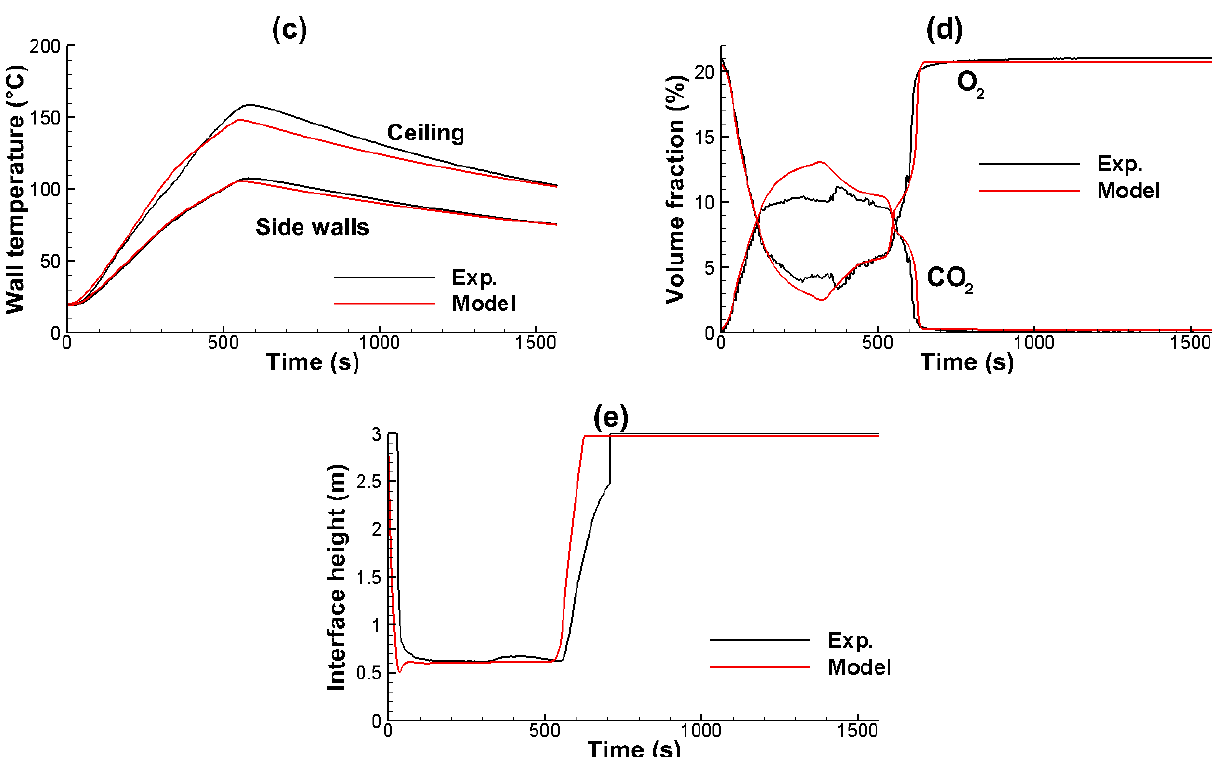
Figure 12. Test 4: ( a ) individual and total HRRs, ( b ) average gas temperature, ( c ) average wall temperatures, ( d ) volume fractions of O 2 and CO 2 in the exhausted gases, and ( e ) smoke layer interface height.